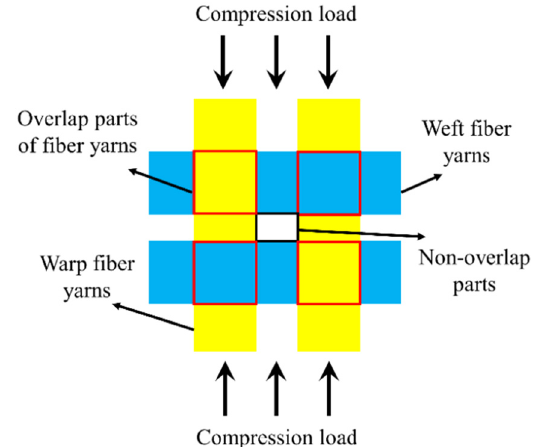
Figure 1: In - situ CT compression experiment.